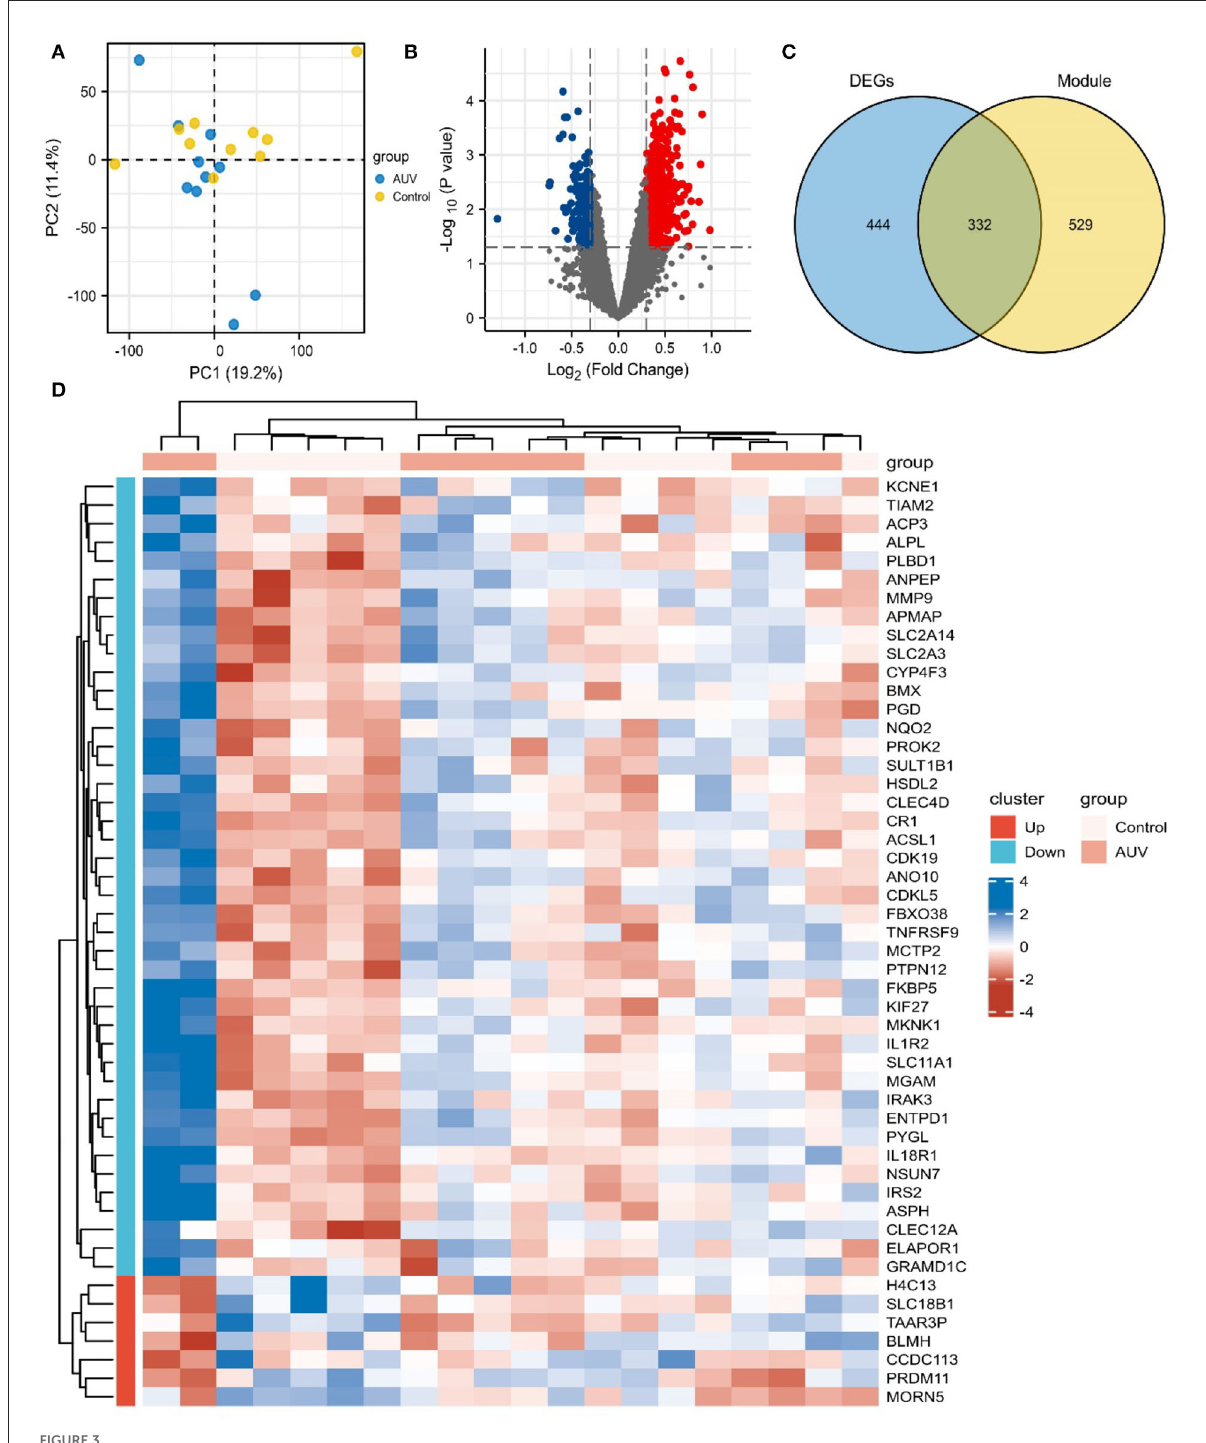
FIGURE3 Identification of differentially expressed genes (DEGs) and Key genes of AUVP. (A) The principal component analysis biplot of the gene expression profiler between patients with AUVP and control samples. (B) Volcano plot of DEGs in AUVP samples. Red: upregulated; Blue: downregulated; Gray: normal. (C) The Venn plot of 332 common genes in the MEdarkturquoise module and DEGs. (D) The Top 50 DEGs of